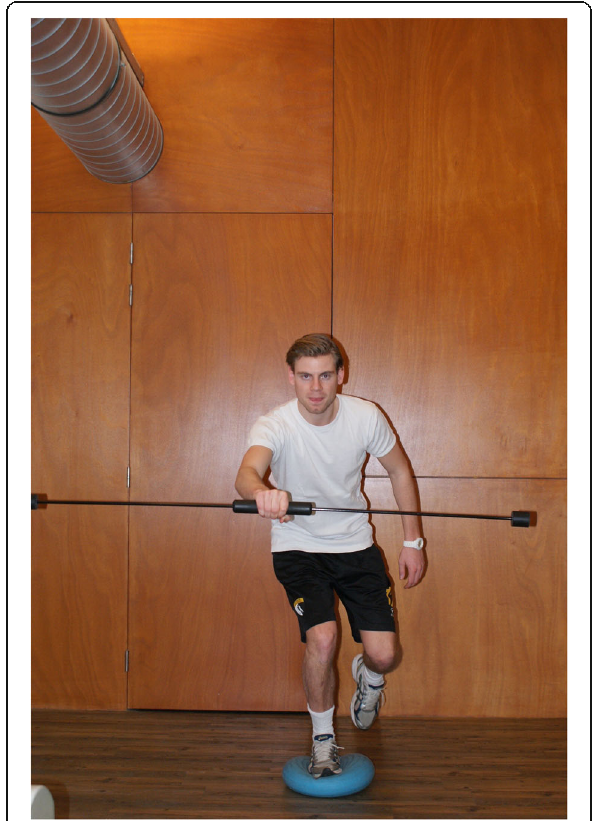
Fig. 2 Postural stability. An athlete is practicing to improve postural stability. To promote an external focus of attention the athlete should be instructed to “ focus on keeping the bar horizontal ”